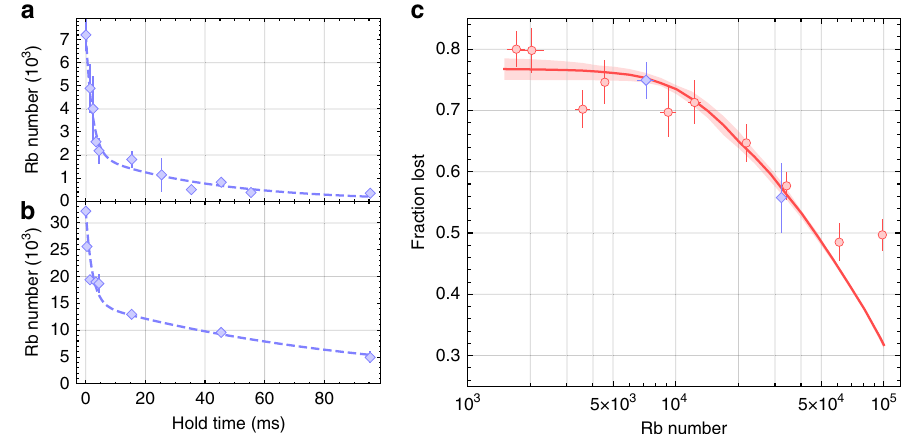
Figure 5 | Measuring the initial atomic distributions with spin-changing collisions. ( a , b ) Sample data for low and high Rb number, respectively. The fraction of Rb remaining after the fast loss is different between the two cases. ( c ) The fraction of Rb lost after B 8ms is plotted as a function of the Rb number in a 25 E R lattice. The blue diamonds correspond to the data shown in panels ( a , b ). At low Rb number, where the Mott insulator has one Rb atom per site, the fraction lost should be equal to the fraction of sites that have a K atom. As the Rb filling increases and the second Mott shell becomes populated, the fraction lost decreases. This technique yields both the filling of K and a measure of Rb atom number that corresponds to the onset of double occupancy of the Rb Mott insulator. All error bars represent 1 (cid:2) s standard